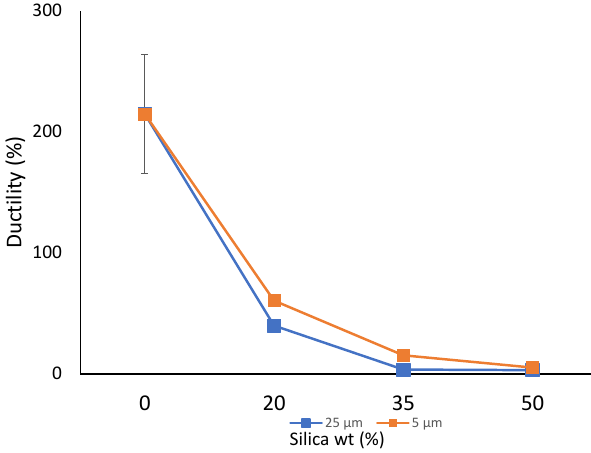
Figure 5. Ductility of the prepared composite sheets.